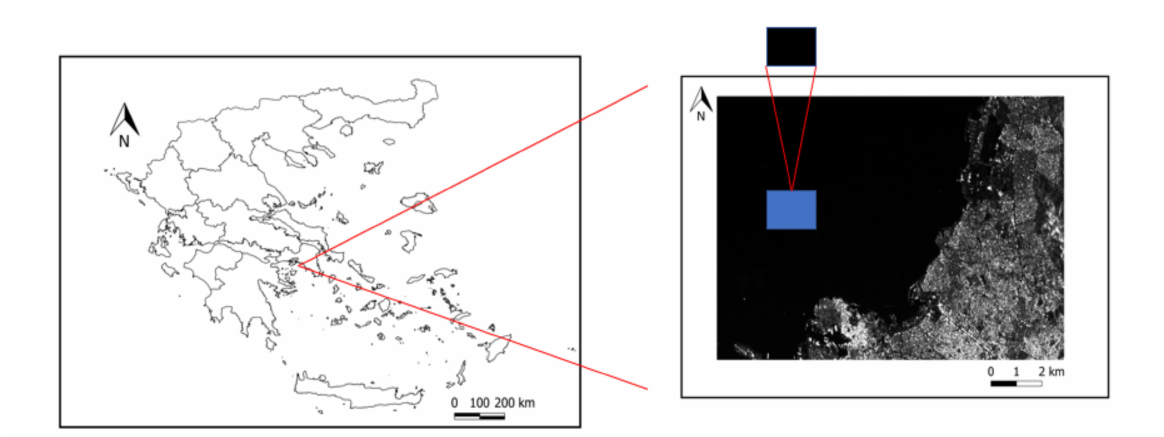
Figure 1. Selecting the pixels from water surface (example from test area,